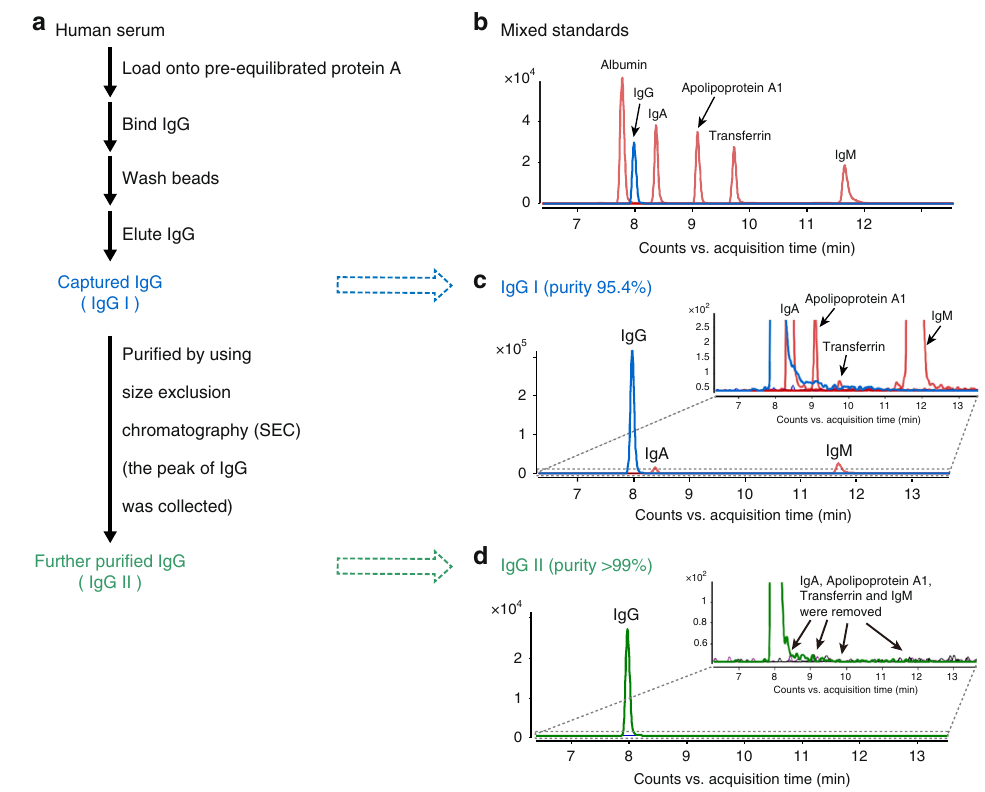
Fig. 2 Capture and further puri fi cation of IgG from human serum. a A fl ow chart of capture and further puri fi cation of IgG from human serum. b MRM chromatograms of unique peptides of six glycoprotein standards (Albumin, IgG, IgA, Apolipoprotein A1, Transferrin, and IgM). c, d MRM chromatograms of unique peptides of IgG and other glycoproteins in captured IgG (IgG I) and further puri fi ed IgG (IgG Methods Further puri fi cation of captured IgG by using SEC method . An Agilent HPLC 1200 system was used for further puri fi cation of captured IgG. The captured IgG (IgG I) was puri fi ed on a Bio-Rad SEC column (Bio-Sil SEC 125-5, 300 × 7.8mm, 5µm), under an isocratic elution by 100mM ammonium formate at a fl ow rate of